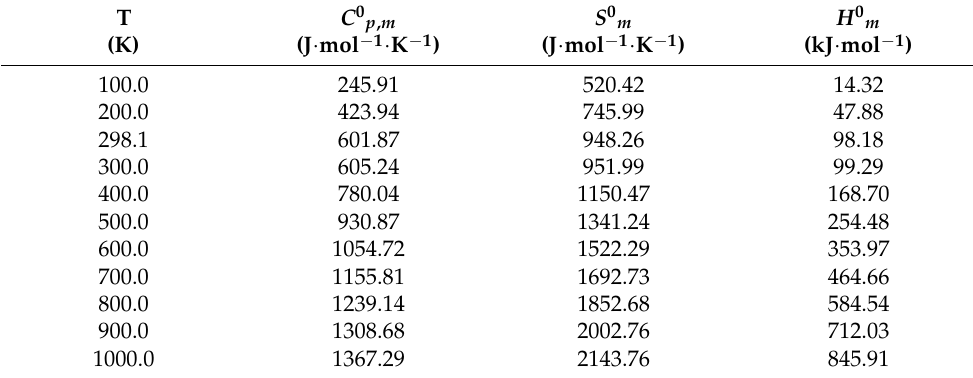
Table 4. C 0 p , m , S 0 m and H 0 m from 100.0 to 1000.0 K at the B3LYP/6-311G (d, p) level.